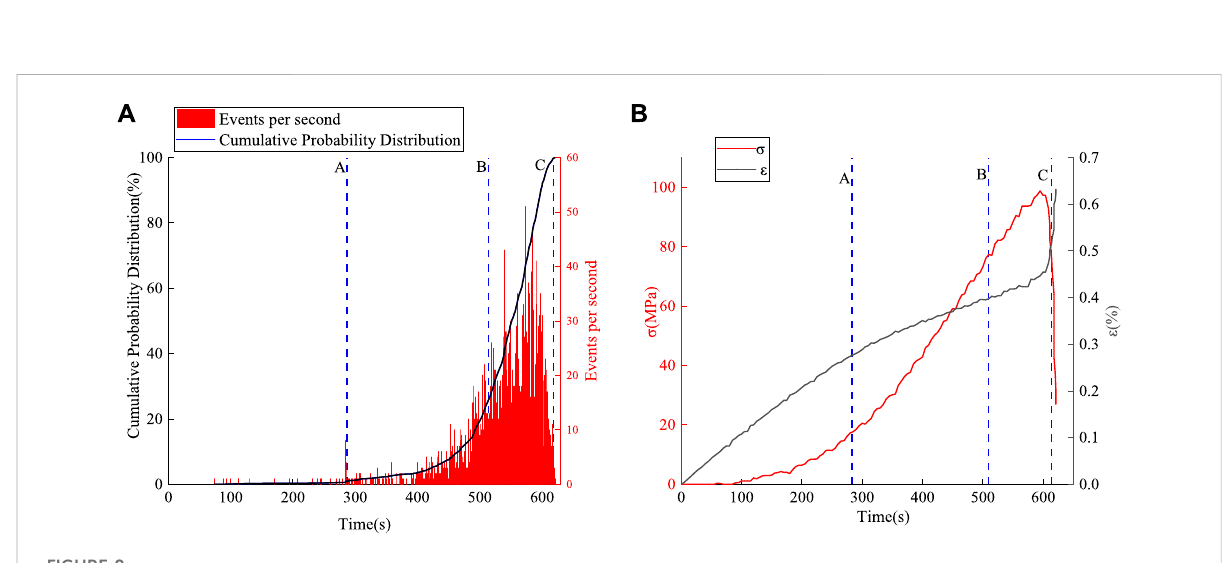
FIGURE 8 ResultsobtainedforspecimenG1: (A) CPDofthefeatureeventsand (B)